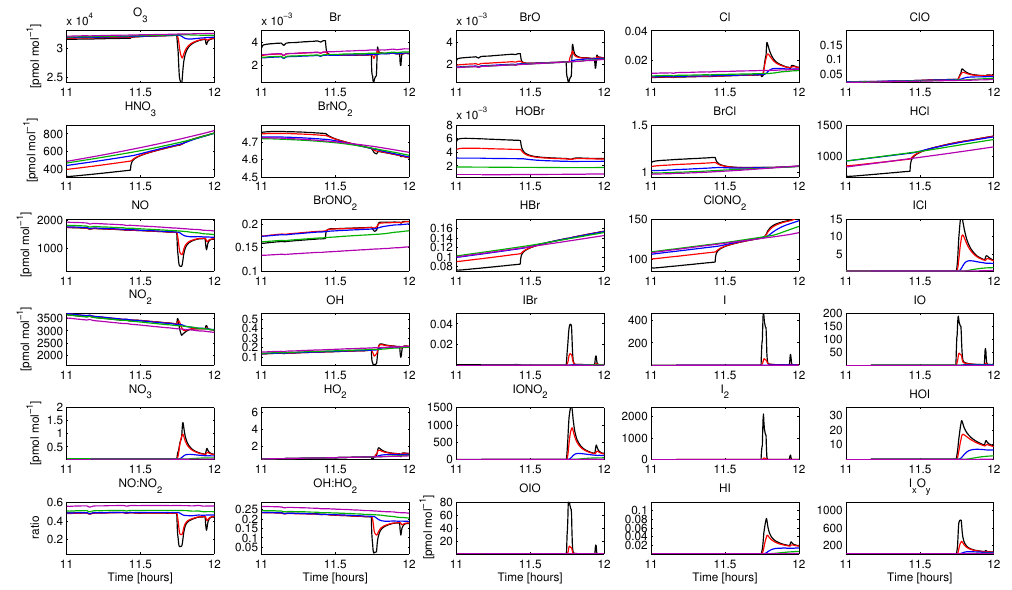
Fig. 3. Mixing ratios of major gas-phase chemical species at different levels through the model column for the base case, low tide, model run. Black, red, blue, green, and purple lines represent mixing ratios at heights of 0.5, 8, 60, 250 and 650m.